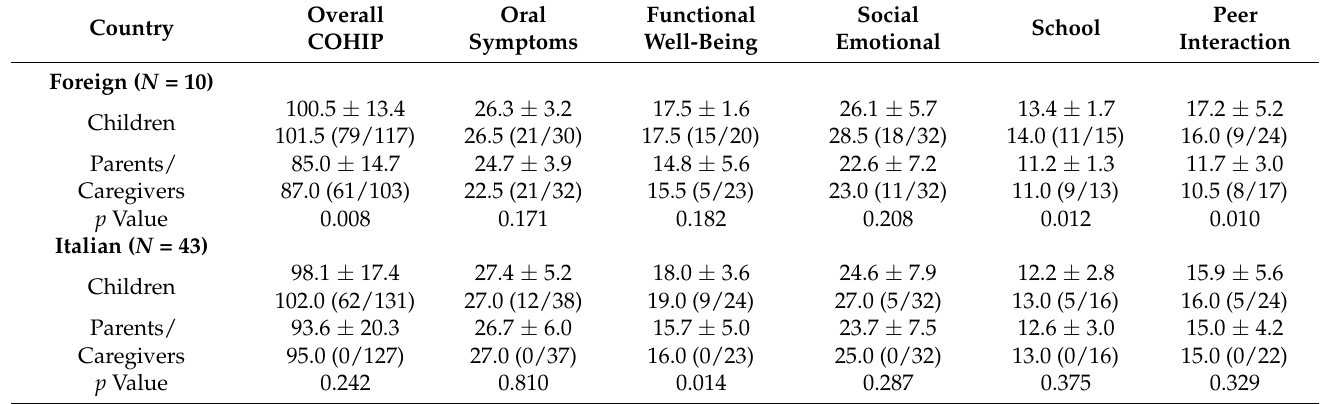
Table 6. Effect of parents’ country on the agreement in COHIP overall and subscale scores between parents and children with cleft [mean ± SD, median,